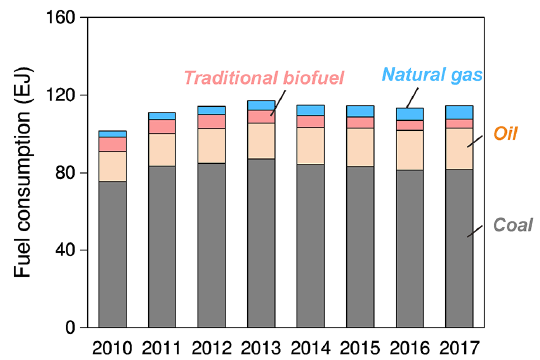
Figure 6. Energy consumption of hydrocarbon fuels from 2010 to 2017. Coal includes all coal-based fuels, and oil includes all oil- based fuels. Traditional biofuel includes crop residual and